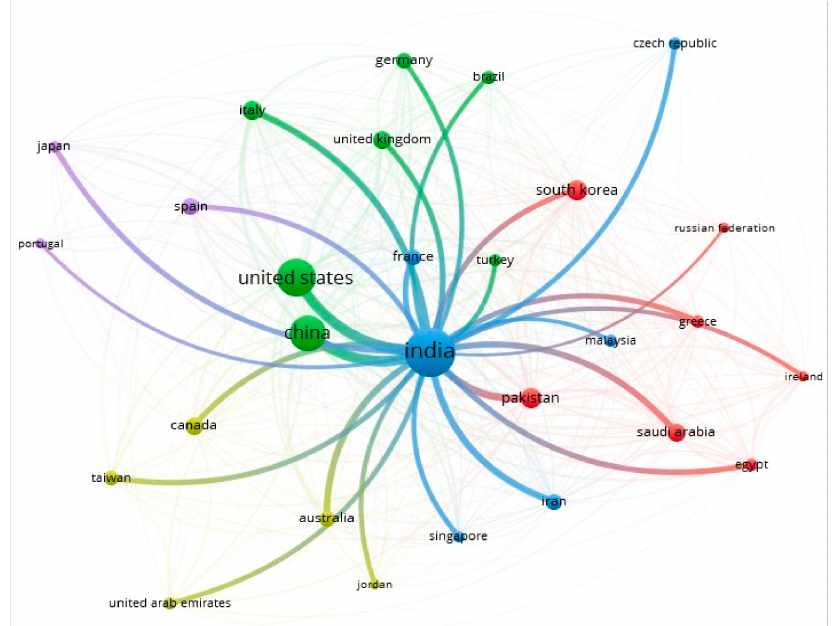
Figure 20. Document X citations.